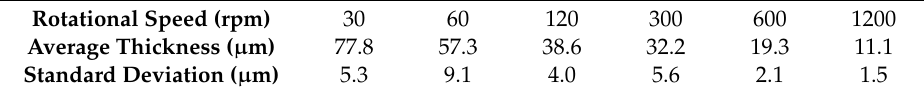
Table 2. Thickness of the PDMS membrane at position B and its corresponding rotational